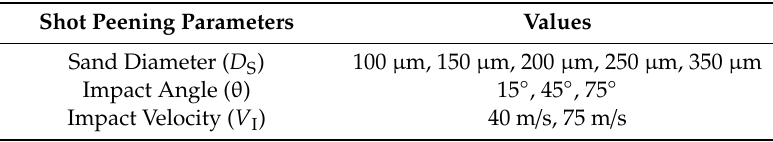
Table 6. The considered parameters for the shot peening FE simulations.